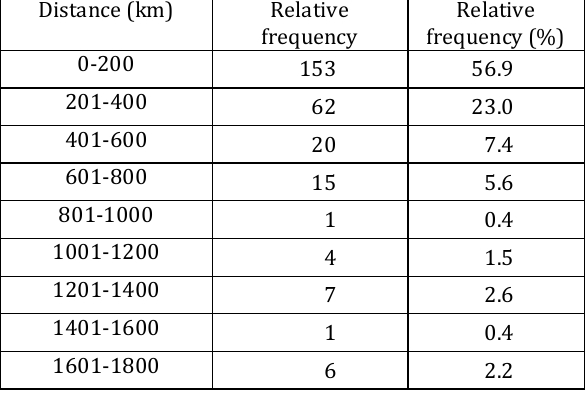
Table4. Distance travelled by forest park visitors